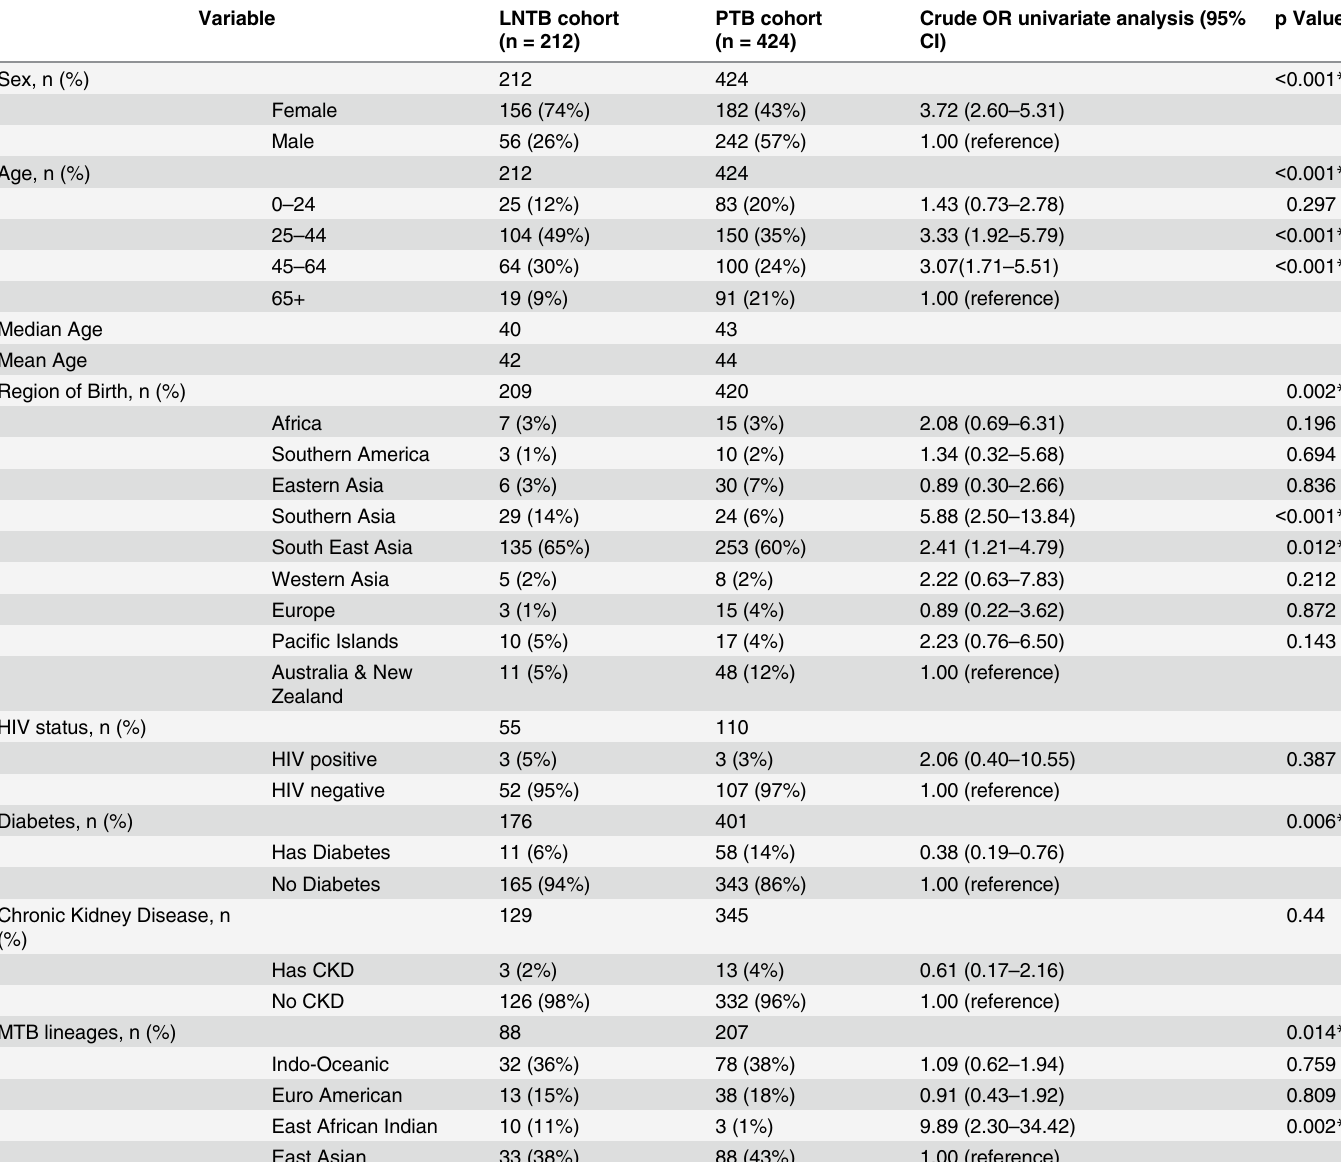
Table 1. Patient characteristics and association with LNTB in univariate